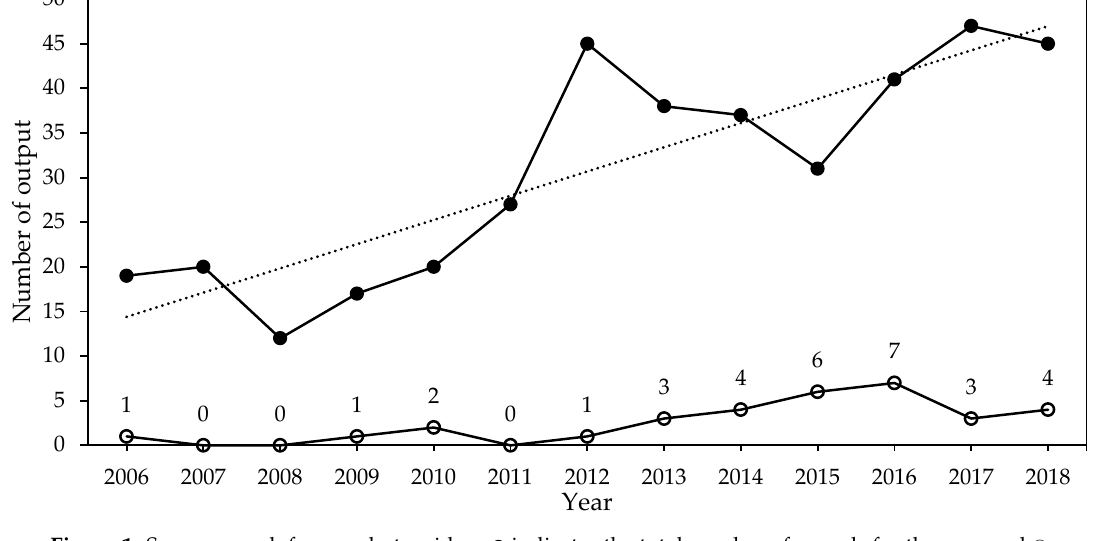
Figure 1. Scopus search for gunshot residue. ● indicates the total number of records for the year and ○ the number of Open Access documents.